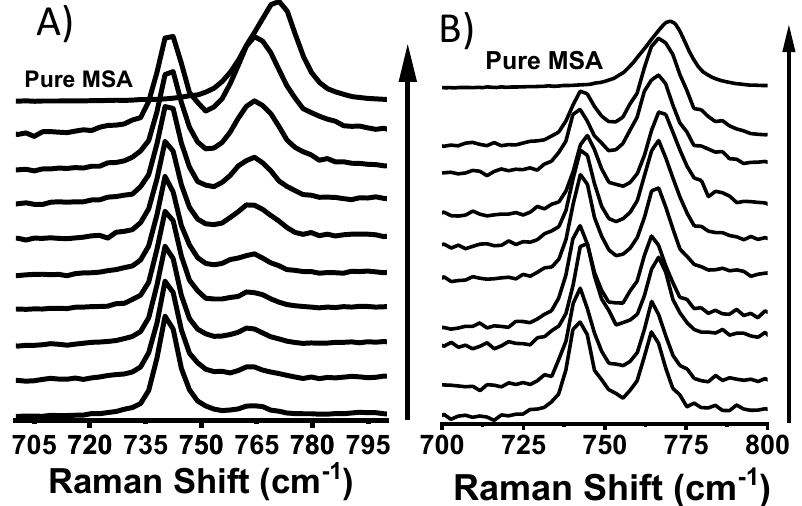
Figure 7. Raman spectra of MSA / HTFSI / PyrrTFSI solutions shown as a function of increasing MSA concentration in constant HTFSI concentrations. ( A ) In 0.4 M HTFSI / PyrrFTSI solutions; ( B ) in 2.0 M HTFSI / PyrrFTSI solutions.